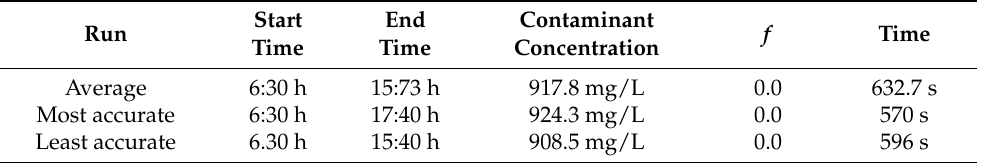
Table 12. Framework 2 results for the Richmond network for the source node 260.